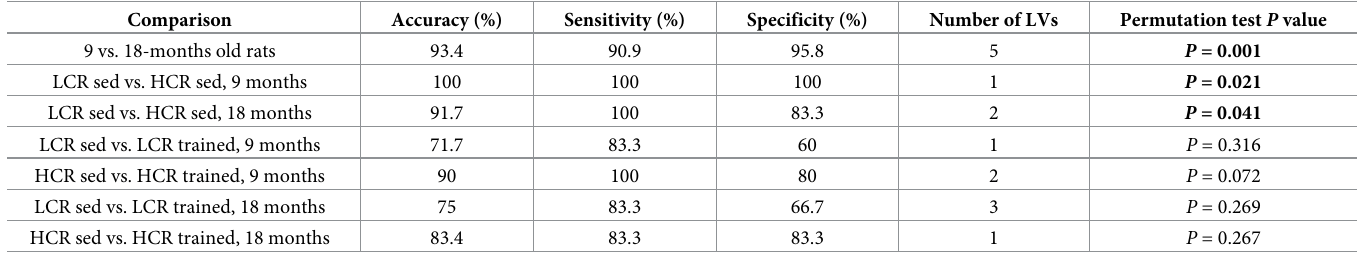
Table 1. Summary of PLS-DA model